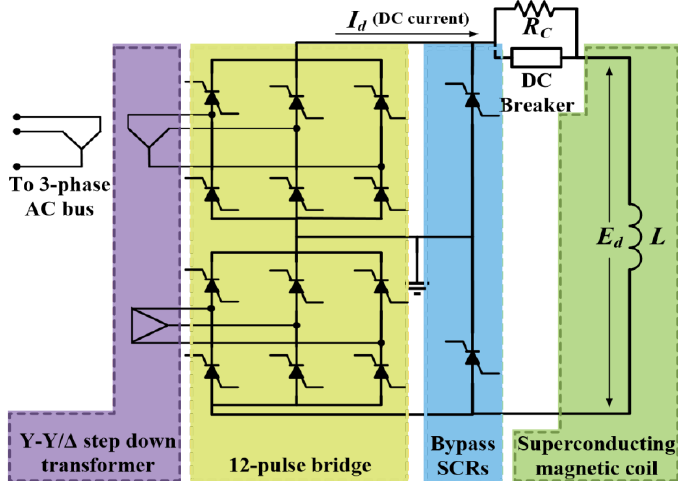
Figure 3. Configuration of SMES